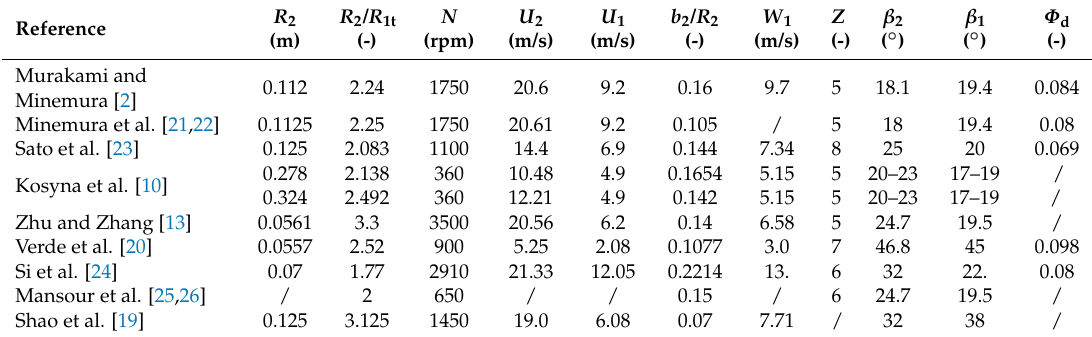
Table 1. Reference list on geometrical and flow parameters of several pump